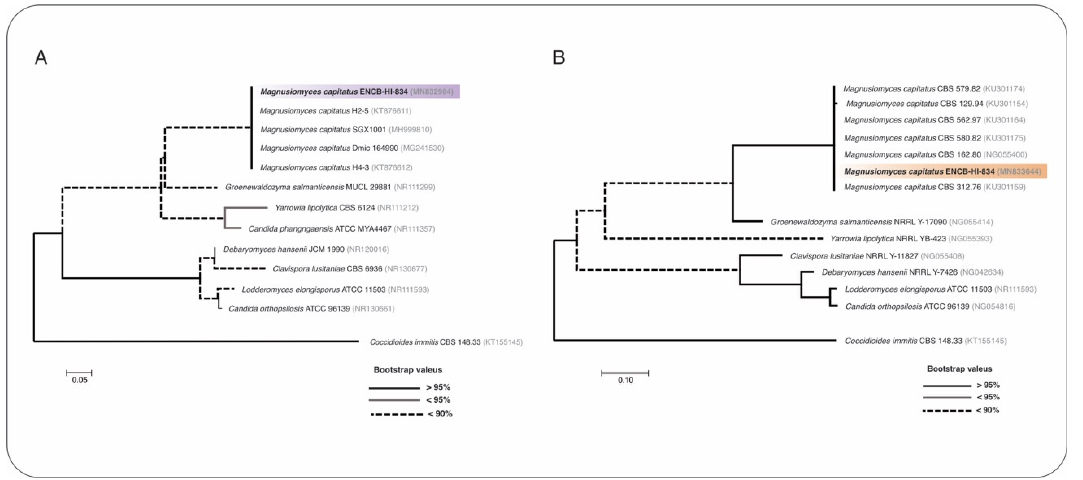
Figure 2. Molecular identification of M. capitatus ENCB-HI-834 was accomplished by using maximum- likelihood phylogenetic reconstruction, performed with sequences from two molecular markers: ( A ) internal transcribed spacer (ITS) and ( B ) 28S. The Jukes-Cantor 69 (JC69) nucleotide substitution test was employed for the generation of phylogenetic trees. The style of the branches represent the Bootstrap val- ues computed with 1000 replicates. Branch lengths are proportional to the number of substitutions per site (see scale bar). The ITS (mauve color) and 28S (orange color) sequences correspond to M. capita- tus ENCB-HI-834. Coccidioides immitis -type strains served as external groups. 3. Discussion Infective complications have been documented during the treatment of children with ALL [18]. Aspergillus , Candida , Cryptococcus , and Pneumocystis have been the most frequently identified fungal pathogens in immunocompromised patients [10]. However, fungal species other than those mentioned above have emerged in recent years, some resistant to conven- tional antifungals as causal agents of IFIs, such as M. capitatus [10]. Since the latter can lead to bloodstream infections and invasive and disseminated multi-organ disease, a timely di- agnosis and treatment is a critical challenge [4]. Most patients with ALL who develop inva- sive Magnusiomyces infection, fungemia, and IFI do so due to profound neutropenia sec- ondary to chemotherapy and after dexamethasone treatment [10,18]. M. capitatus , recently defined as an emerging pathogen, is mostly found in patients with hematological malignancies, particularly acute leukemia. For instance, it was detected in an adult male diagnosed with ALL and hospitalized in Mexico City’s General Hospital. IFIs in children with ALL have been scantly reported. The current contribution details a case of systemic fungal infection by M. capitatus ENCB-HI-834 in a patient admitted to the Chil- dren’s Hospital of Mexico City. Systemic infections caused by M. capitatus have been mainly documented in the Mediterranean countries of Europe, including Italy, France, and Spain [1,19,20]. They have also been reported in other areas of Europe (Slovakia, Switzerland, and the Czech Republic) [4] and in Asia (India, Nepal, Kuwait, and China) [21–23]. In the Amer- icas, M. capitatus was recently isolated from an alcoholic male patient in the United States [24]. The conventional methods for recognizing M. capitatus as the agent of an IFI have not provided consistently accurate results. For example, S. clavata is frequently confused with S. capitata and vice versa because they are identical macroscopically and microscopically [10] . Therefore, phylogenetic reconstruction methods were employed for the characterization of the fungal strain. Molecular identification and phylogeny have been used previously for the de- tection of M. capitatus and its differentiation from closely related species such as S. clavata [24– 26] . These techniques were instrumental for recognizing M. capitatus ENCB-HI-834 as the agent of the present systemic infection. The examination of samples by the molecular se- quences of ITS and 18S can probably help to establish the relationship of M. capitatus strains from various geographical sites. However, we suggest that phylogenomic studies derived